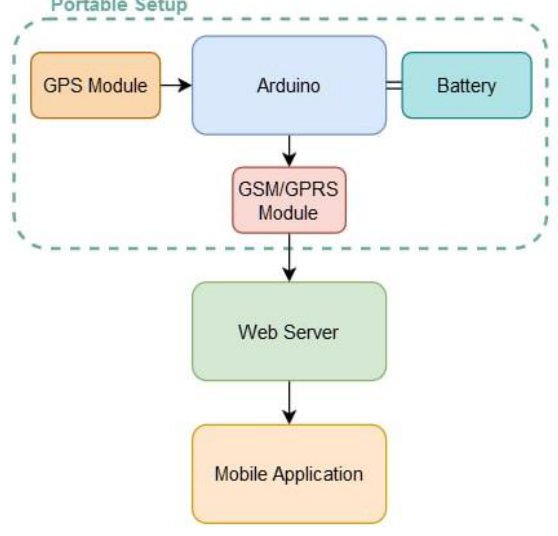
Figure 3. The architecture of the designed system.